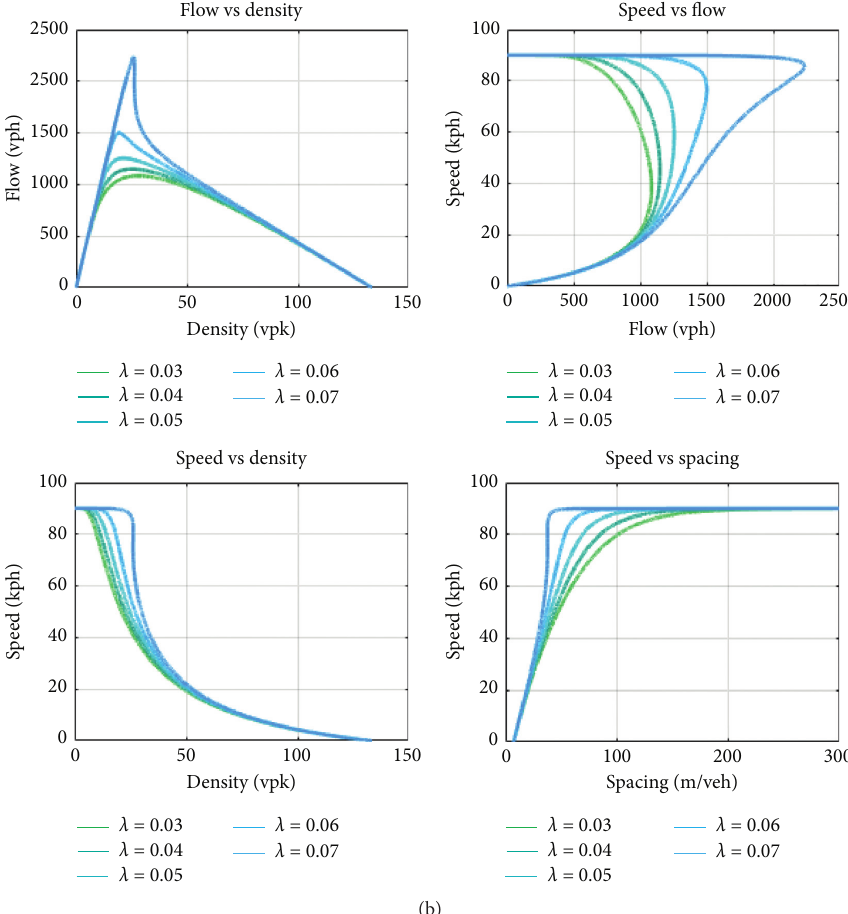
Figure 3: Variability of the fundamental diagram resulting from changes in the (a) spacing sensitivity parameter and (b) speed sensitivity